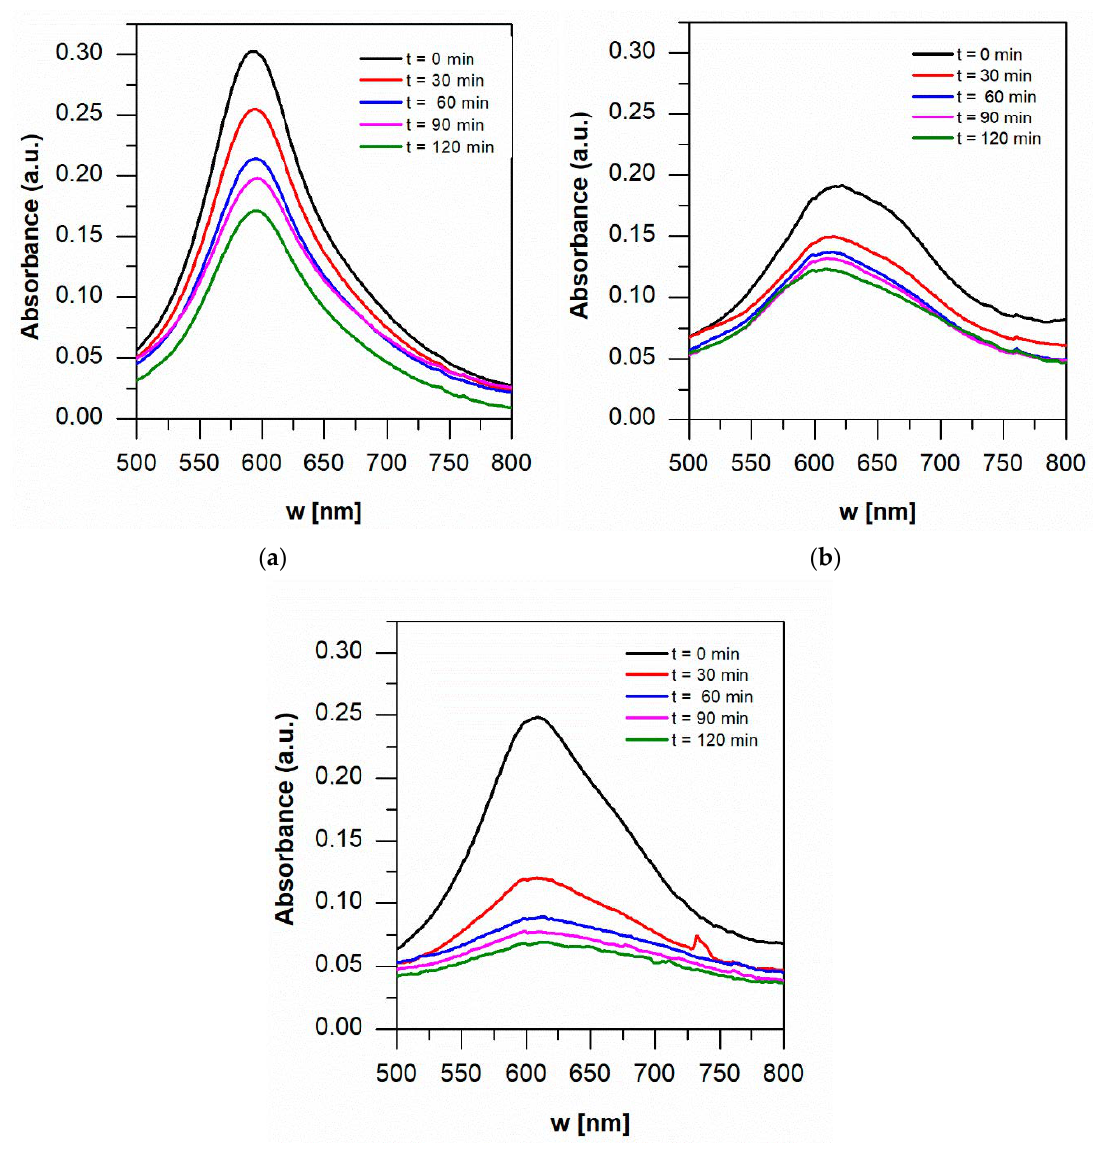
Figure 8. Visible absorption spectra of 1 mM aniline blue in 25 Ma samples at ( a ) pH 7, ( b ) pH 3 and ( c ) pH 3 + O 2 . t = 0 is after dark adsorption.